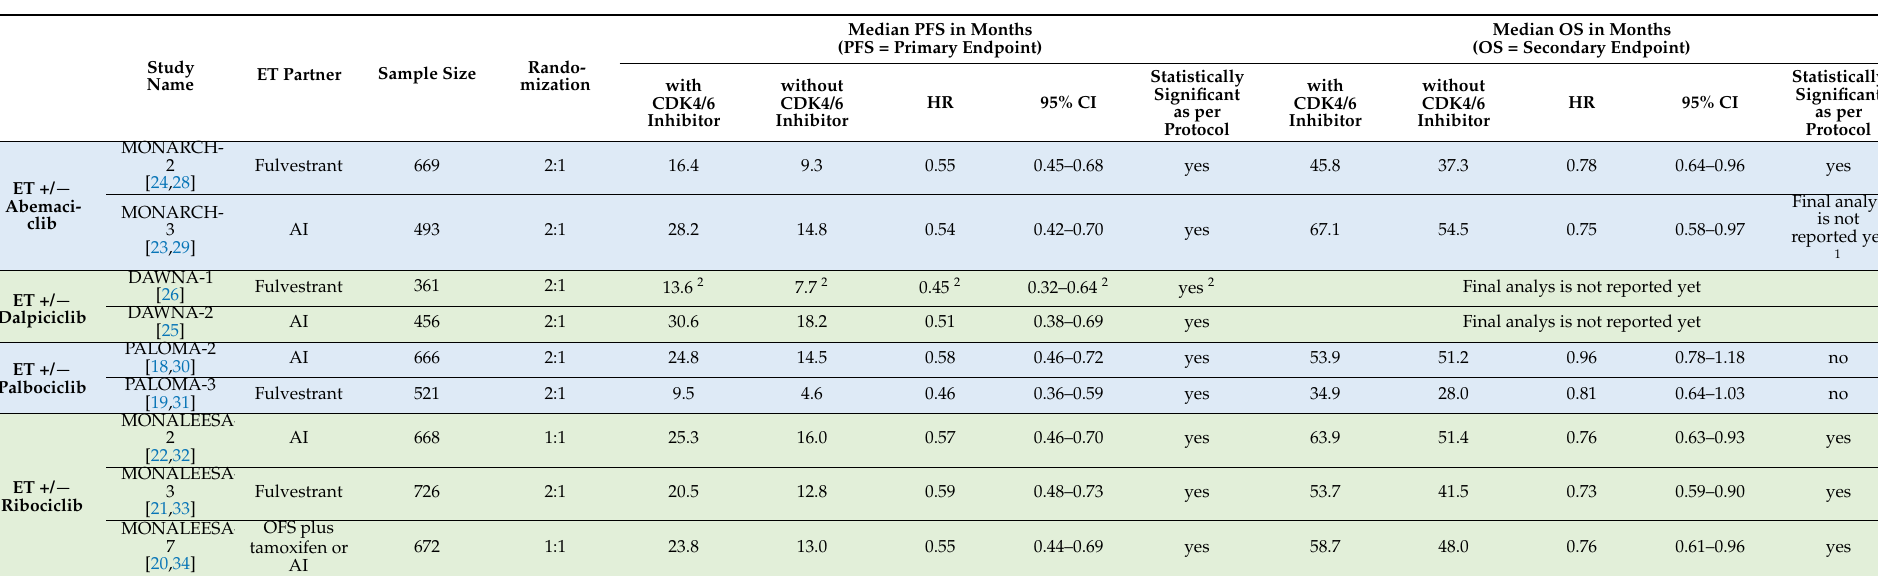
Table 1. Efficacy of CDK4/6 inhibitors in hormone receptor-positive, HER2-negative aBC phase III trials (in alphabetical and numerical order; adapted and updated from